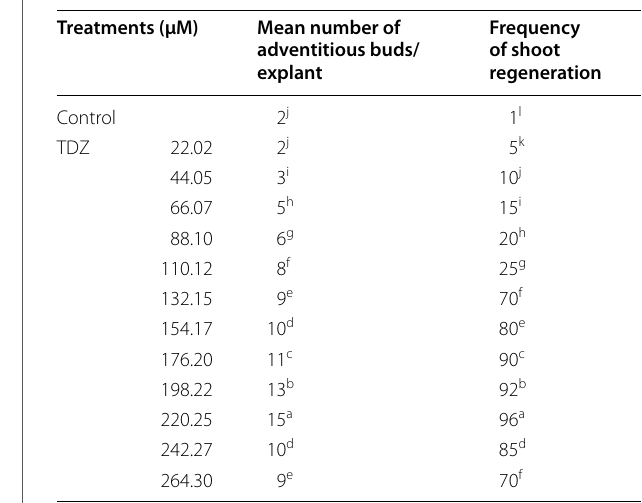
effect of TDZ on direct organogenesis formation from L. barbarum leaf